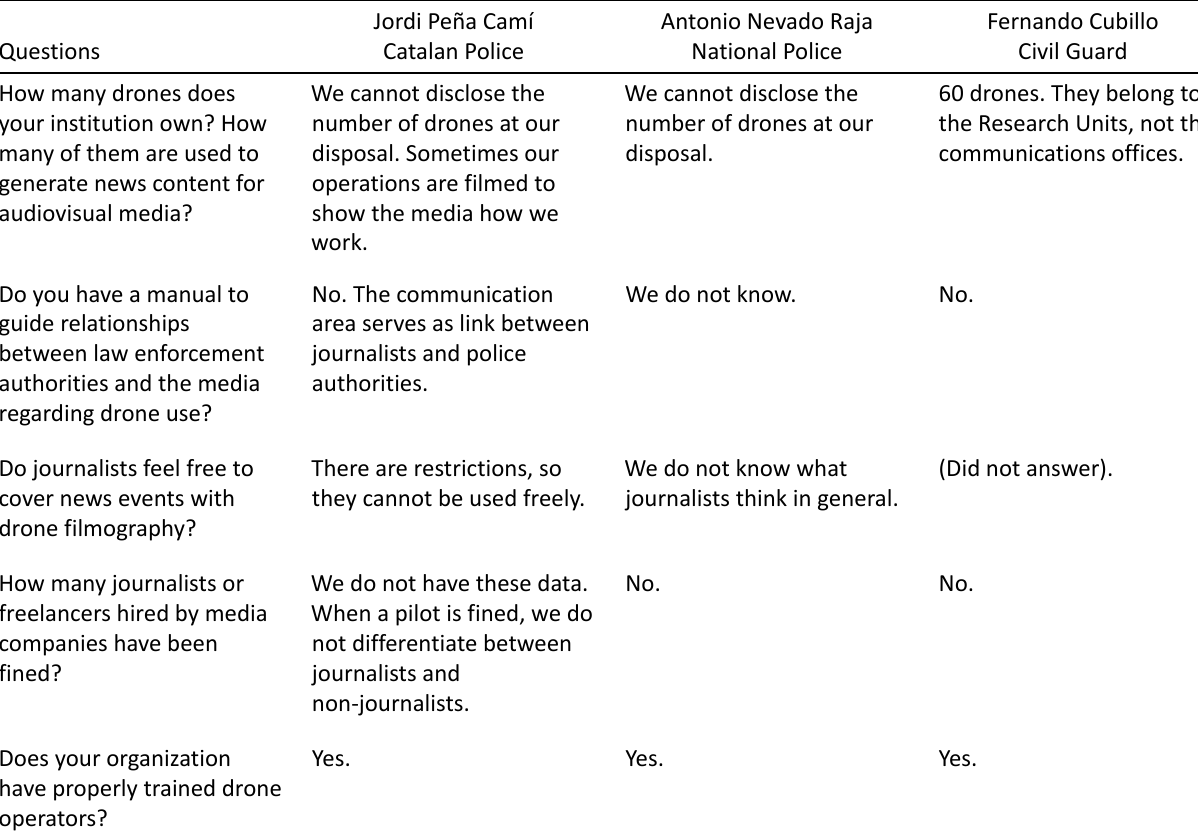
Table 3. Summary of answers provided by the panel of experts representing the Security Forces and